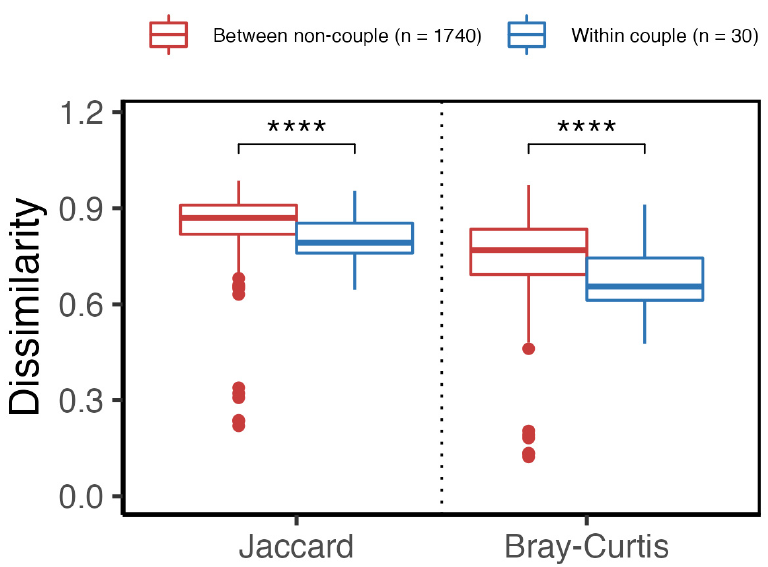
Figure 2. Dissimilarity between each pair of individuals. The “Between non-couple” dissimilarity values were calculated from pairs of non-coupled individuals, and the “Within couple” dissimilarity values were calculated from pairs of couples. The p -value above each bracket shows the significance between “Within couple” and “Between non-couple” for each dissimilarity index. ****: p < 0.0001. See Supplemental Table S3 for exact p -values.